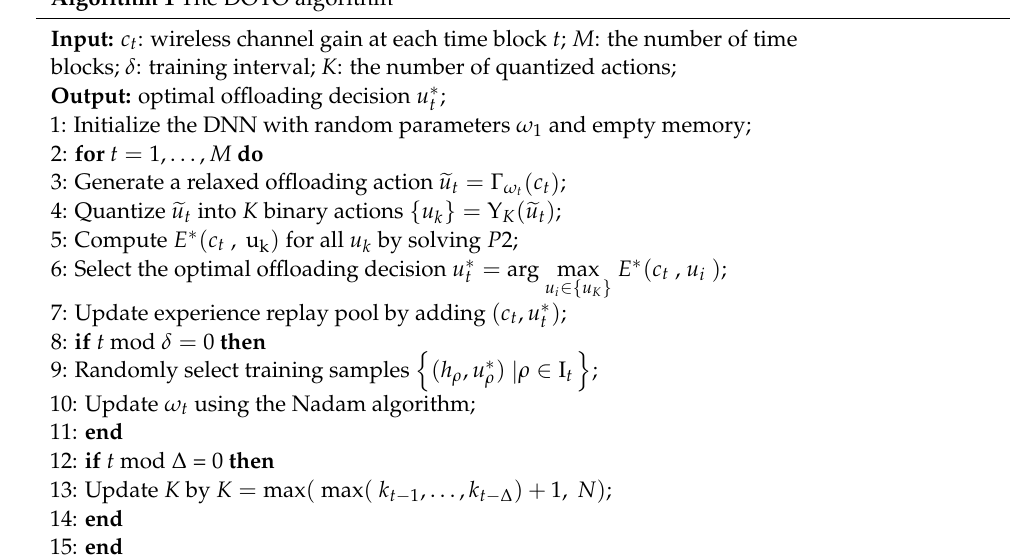
Algorithm 1 The DOTO